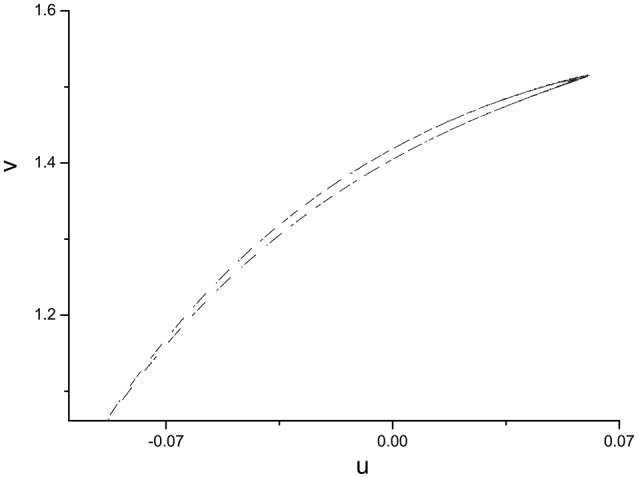
Enlarged view of Figure 2B, A close circle in Poincáre section as ω = 0.4.